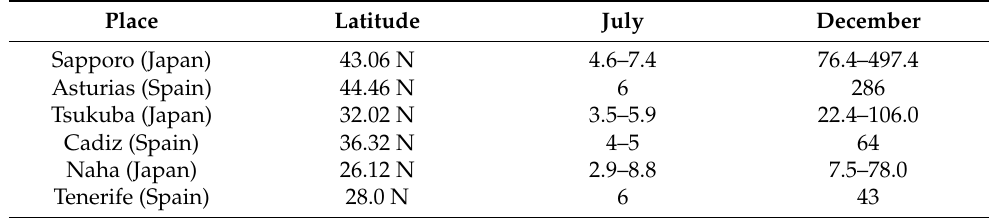
Table 3. Sun exposure required (in minutes) to produce 100 IU of vitamin